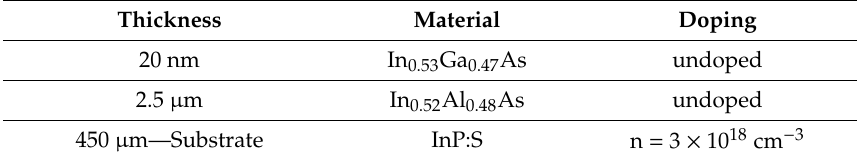
Table 1. Schematic of test samples structure used to study In 0.52 Al 0.48 As growth optimization versus the parameters of MBE: substrate temperature and V / III BEP